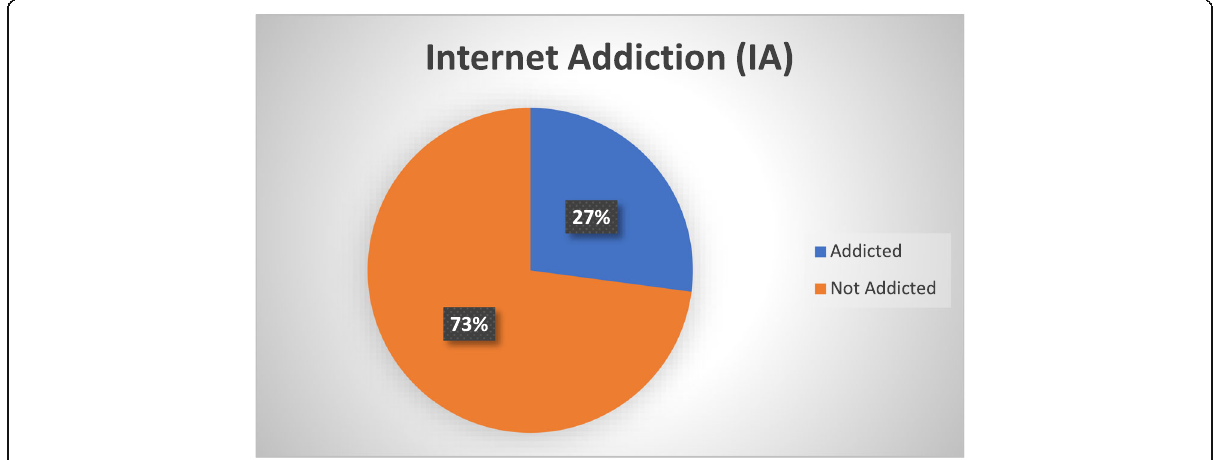
Fig. 1 Prevalence of internet addiction among young adults in Bangladesh,